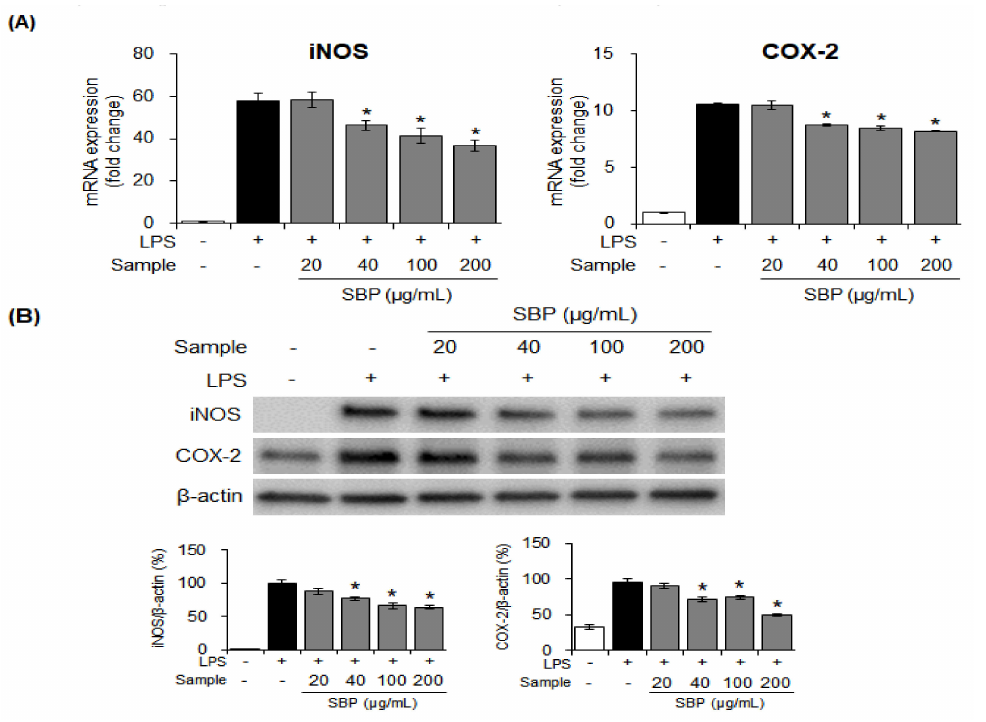
Figure 3. Effects of the SBP extract on mRNA and protein expression of iNOS and COX − 2 in Raw264.7 cells. ( A ) mRNA and ( B ) protein expression. Data are expressed as mean ± SEM. Significantly different from the LPS − treated group (* p < 0.05). SBP, sword bean pod; LPS, lipopolysaccharide; iNOS, inducible nitric oxide synthase; COX-2,